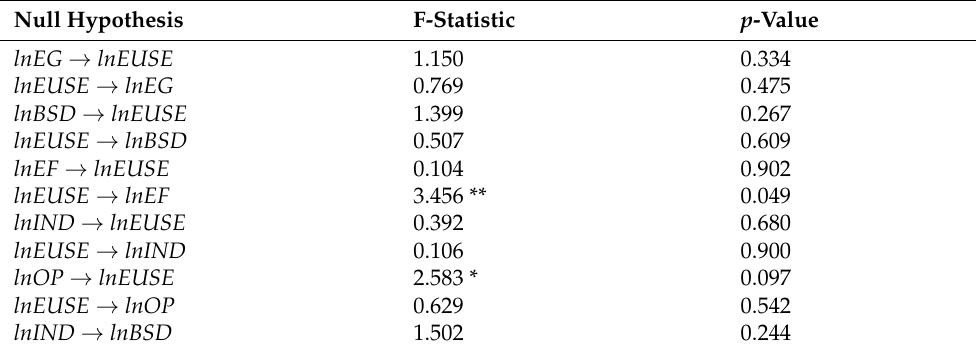
Table 7. Results of the Pairwise Granger causality testing